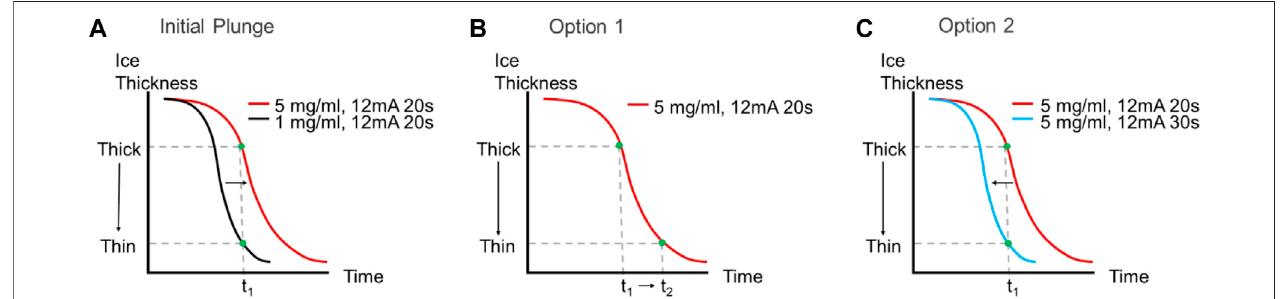
FIGURE 5 | Effect of increased sample concentration on ice thickness and dispense-to-plunge time. (A) The same sample at higher concentrations will lead to thicker ice observed on the grid if the dispense-to-plunge time and glow discharge strength are both held constant. There are two options to obtain thinner ice with a moreconcentratedsample:eitherincreasethedispense-to-plungetime[ (B) ,Option1]orincreasetheglowdischargetime(orcurrent)andkeepthedispense-to-plunge time constant [ (C) , Option